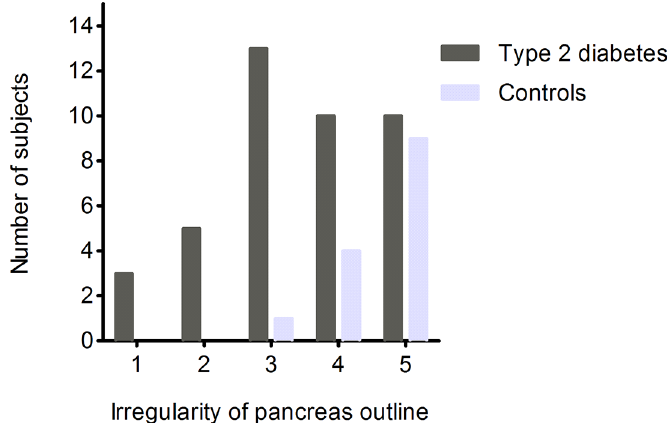
Fig 5. Semi-quantitive analysis of the irregularity of pancreas outline. Red: type 2 diabetes individuals; Green: non-diabetic control individuals. Most irregular = 1 and least irregular = 5. It can be seen that most non-diabetic individual have a smooth pancreas outline whereas many people with type 2 diabetes have an irregular pancreas border. The distributions of scores are significantly different (p < 0.002; Mann-Whitney U